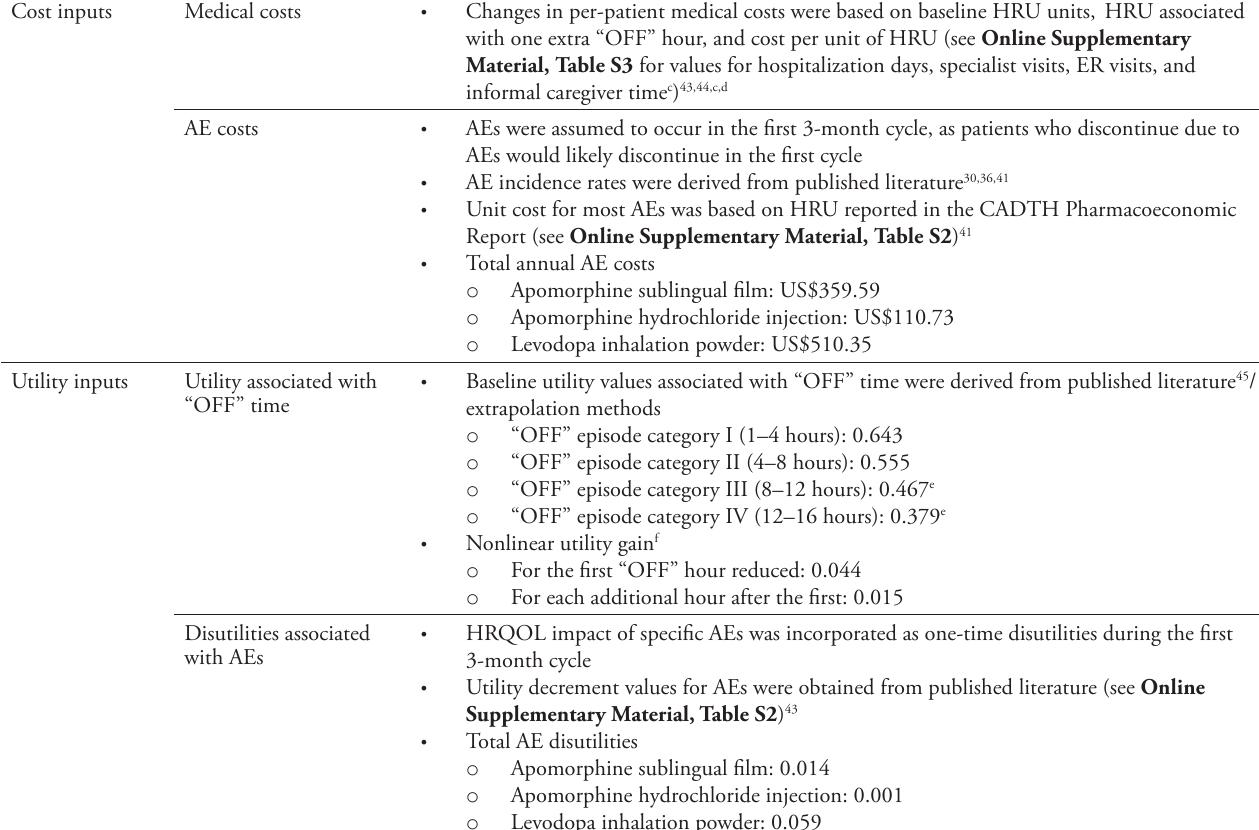
Table 2. Cost-Effectiveness Analysis Model Inputs Cost